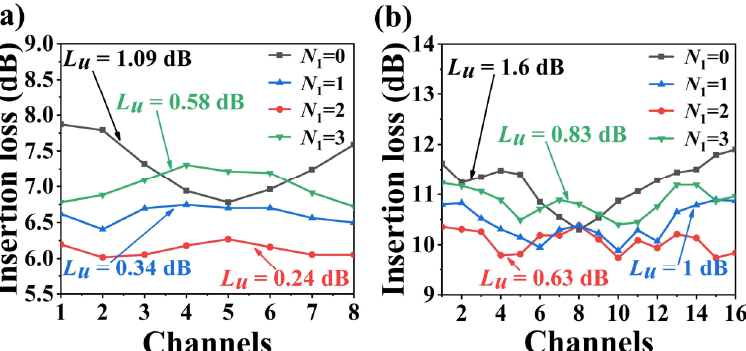
Figure 3. Simulated non-uniformity and insertion loss for all output channels of ( a ) 8 and ( b ) 16- channel nanowire-assisted AWG with the variation of N 1 .